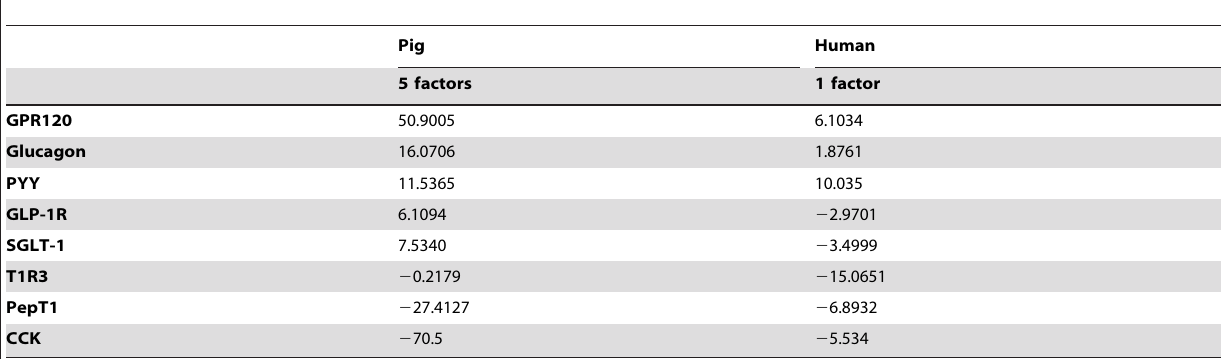
Table 1. Loading vectors of the pig and human PLS model.